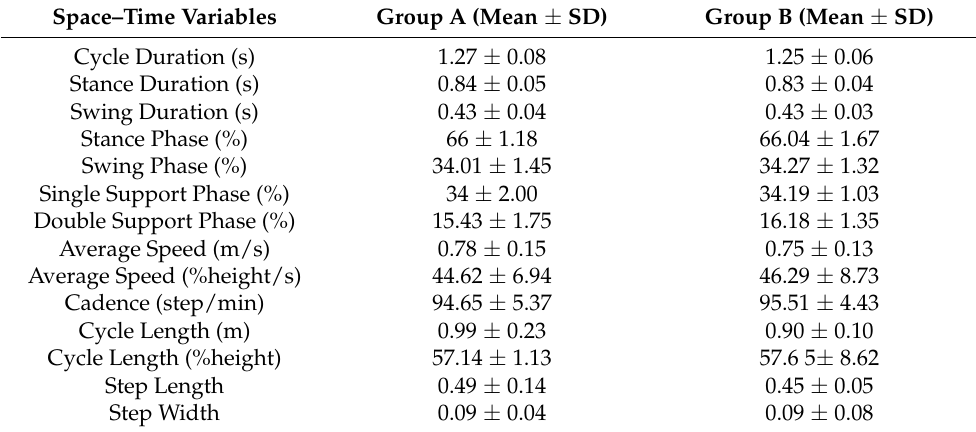
Table 4. Space–time parameters. No significant variation was found between Group A and Group B